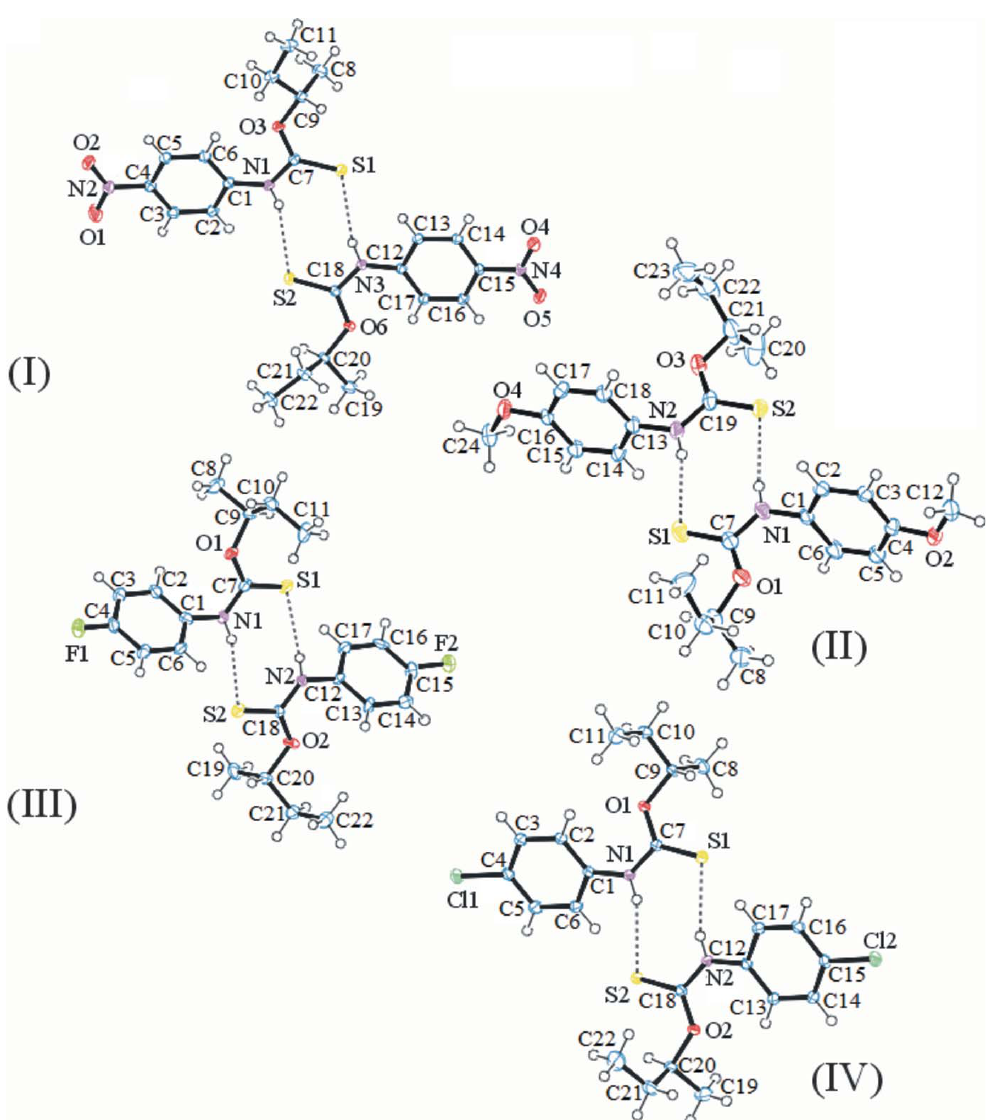
Figure 1 The molecular structure of (I)–(IV), with non-H atoms labeled and 50% probability displacement ellipsoids for non-H atoms. Hydrogen bonds drawn as dashed lines. Disorder omitted for